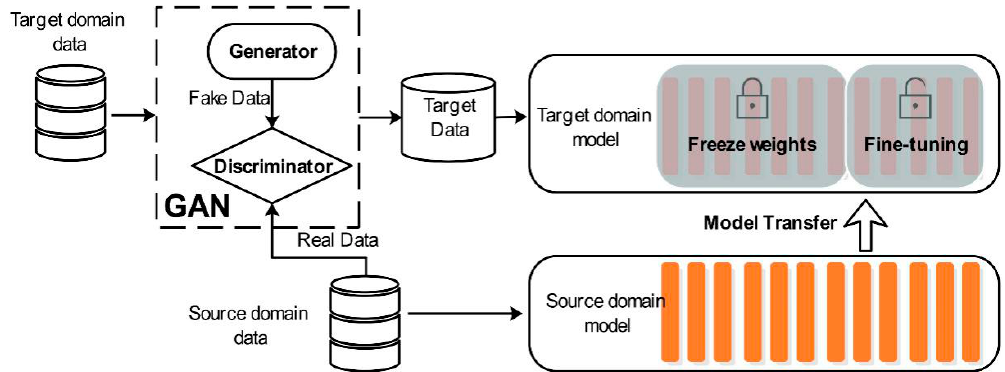
Figure 15. The domain adaptation is achieved by the generative adversarial network, and the target model is fine-tuned by the target variable of the target domain.